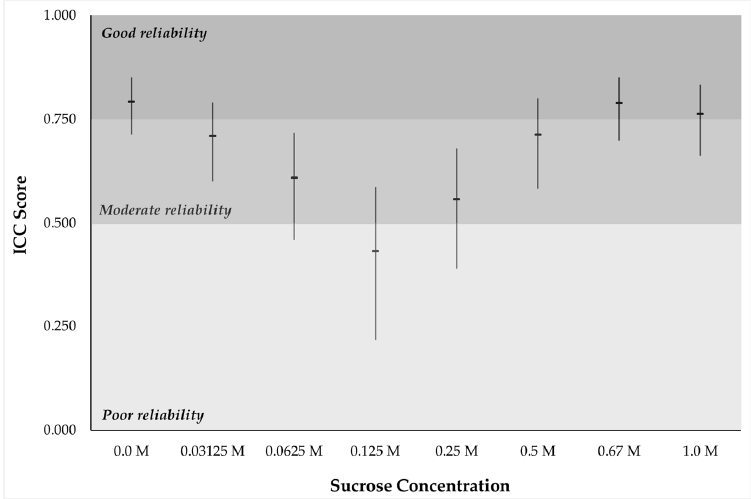
Figure 2. Interclass correlation coefficient (ICC) scores (95% confidence interval) for liking ratings from the two taste test blocks across the different taste stimuli.